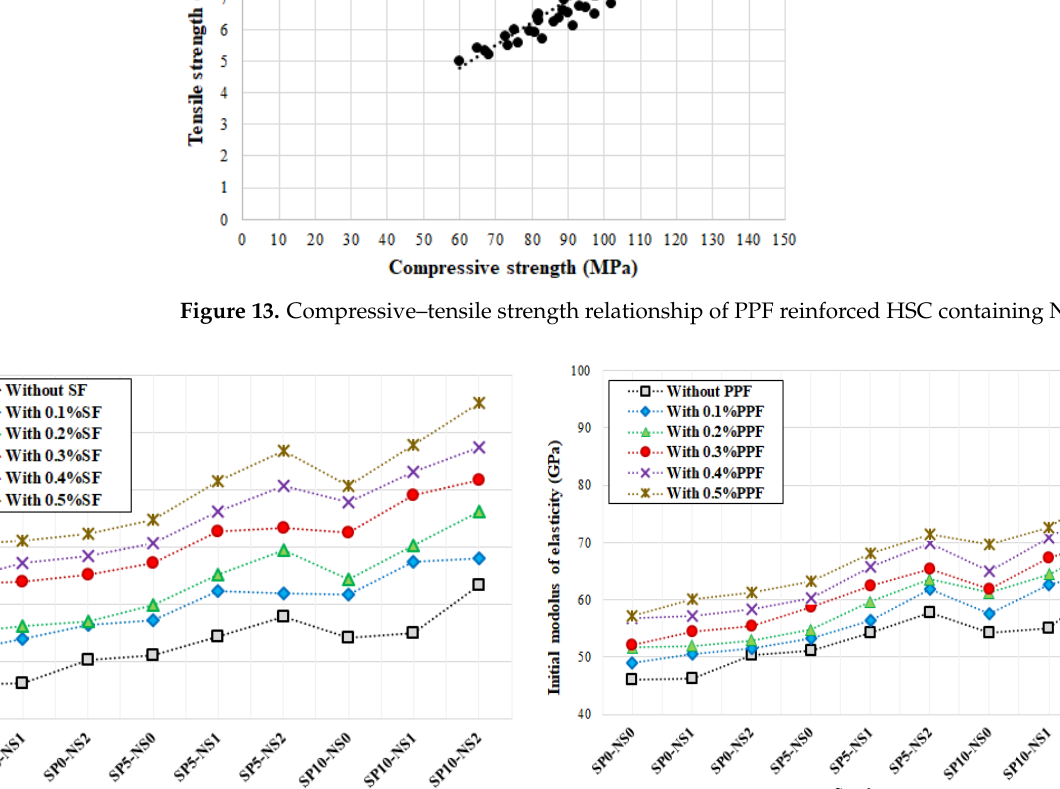
Figure 14. Effect of fibre on the initial modulus of elasticity of HSC containing NS and SP ( a ) SF and ( b ) PPF.